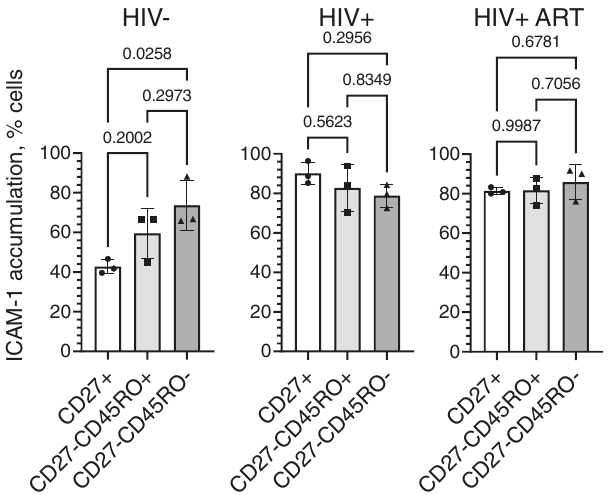
Fig. 2 | Fraction size of CD8 T cells accumulating ICAM-1 at synaptic interface depends on T cell differentiation stage and donors ’ status. CD8 T cells derived from PBMC of HIV − or chronic HIV+ or ART-treated HIV+ individuals were sub- divided into CD27+, CD27-CD45RO+ and CD27-CD45RO − subsets by magnetic sorting. Isolated T cell subsets were exposed to bilayers containing labeled anti- CD3 and ICAM-1 molecules, and ICAM-1 accumulation were observed at the inter- facefor30min.BargraphswitherrorbarsindicatemeanvalueswithSDs.Eachdot point represents independent experiment ( N =3 for each donor group). The dif- ferences between fraction size within a subject group were determined using ordinary one-way ANOVA with Tukey multiply comparison test; exact adjusted p values indicated on the top of the graphs. Source data are provided as a source data fi